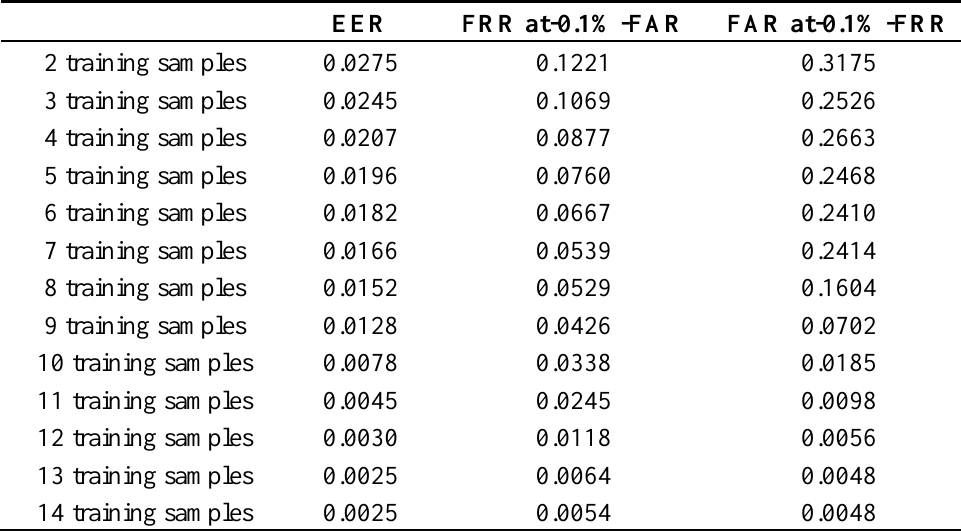
Table 4. Verificaion of performance with different numbers of training